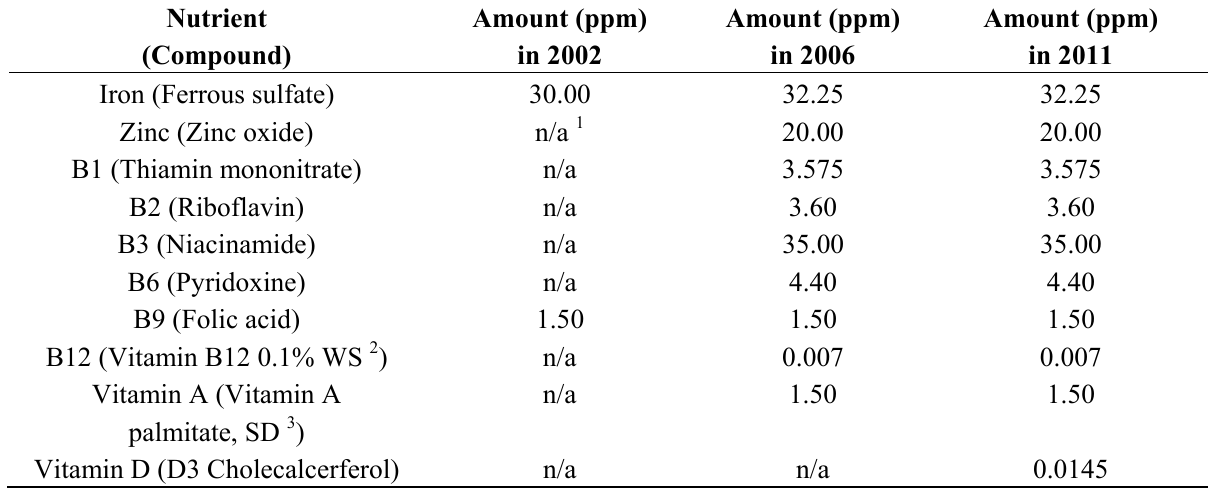
Table 1. Micronutrient premix standards in 2002, 2006, and